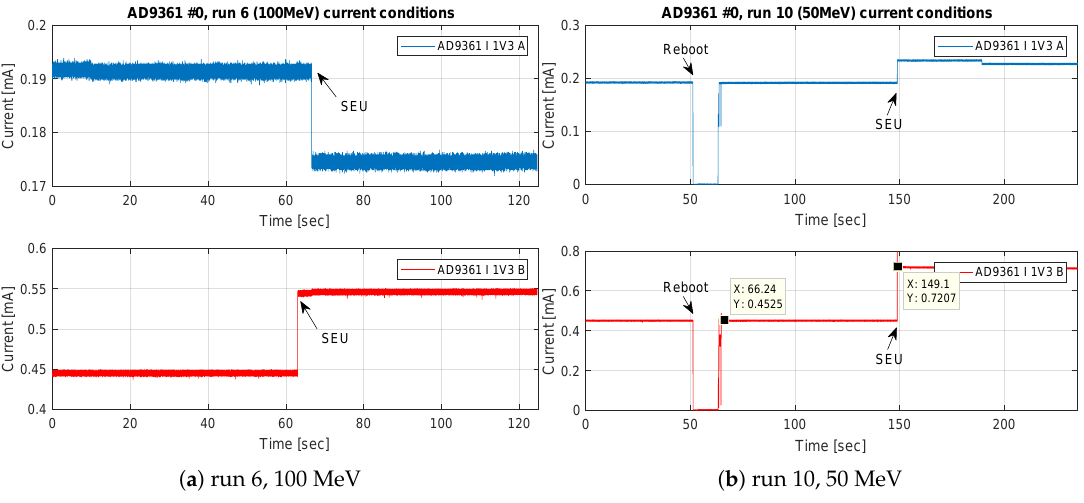
Figure 10. Current conditions on the DUT 1.3V power rails ( a , b ), after SEU events (Sample 1, Runs 6 and